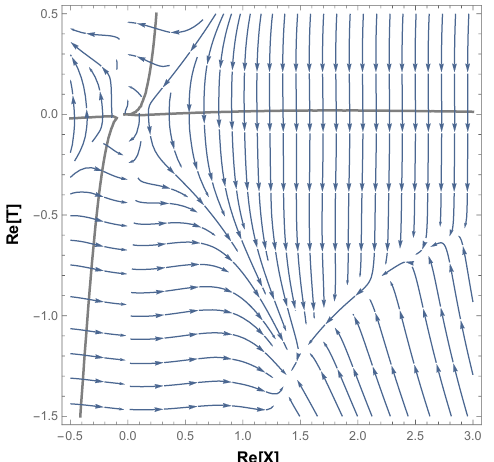
Figure 4 . The figure shows the stream-plot of the (negative) gradient of the scalar potential with RG time t = 0 . 1 for S = 114 . 9 and A = 1 , a = 0 . 1 , W 0 = − 10 − 4 , ξ UV = 1 and P = 80 near the origin of the ( X , T ) field space. The black contour shows the location where the Re S component of the gradient vanishes as well. The “minimum” at X = 1 . 42 , T = − 1 . 27 no longer has a non- vanishing gradient along the S